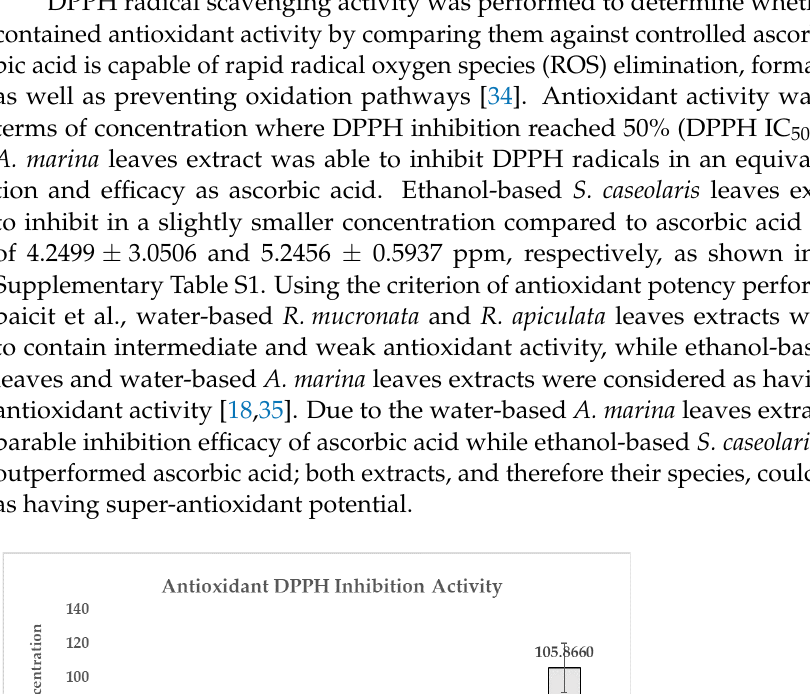
Supplementary Table S1. Using the criterion of antioxidant potency performed by Phong- paicit et al., water-based R. mucronata and R. apiculata leaves extracts were considered